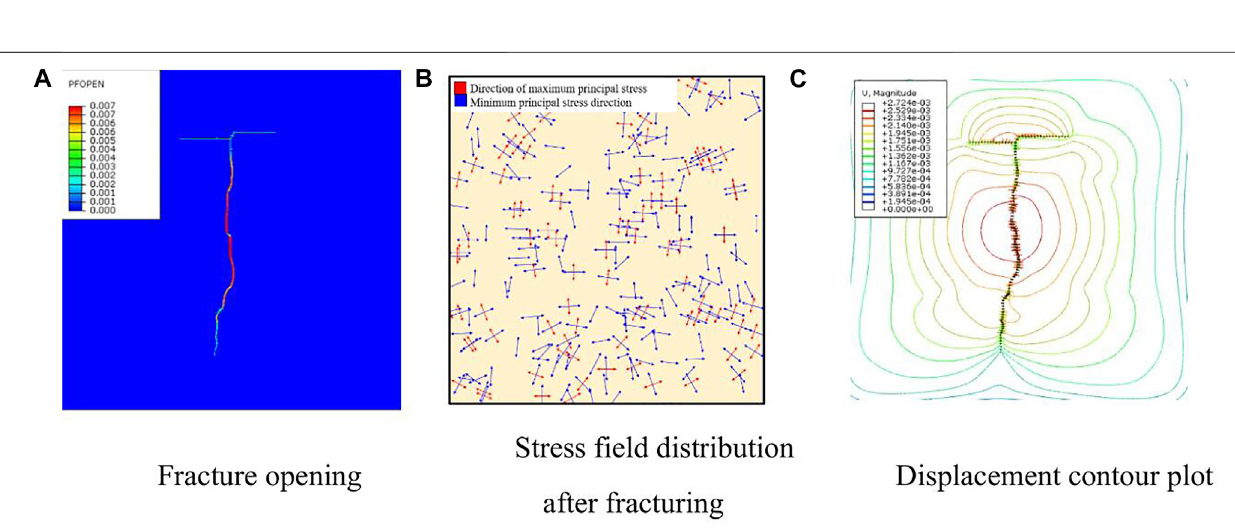
Frontiers in Earth Science |